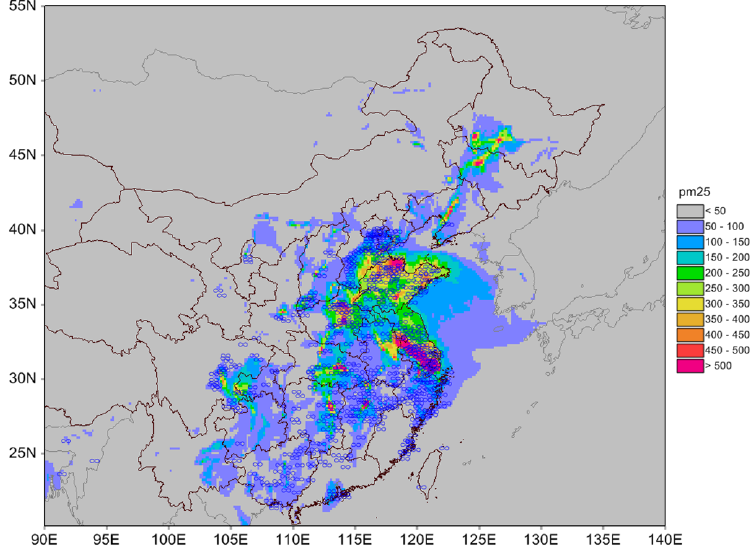
Figure 2. Simulated PM 2 . 5 (shaded) and haze weather phenomena observed at 14:00UTC (22:00LT), 7 December 2013.